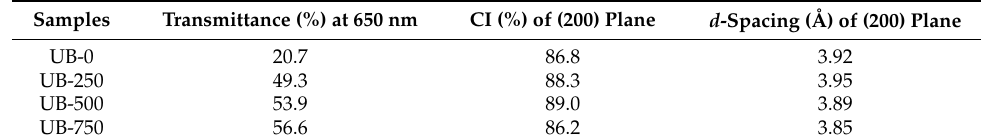
Table 1. Transmittance from Figure 1f, CI for different BC films.